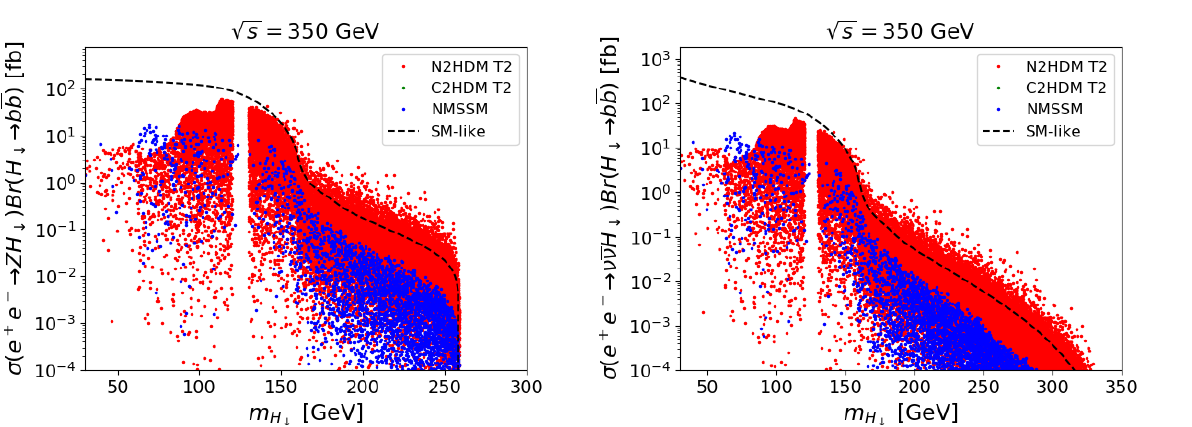
Figure 20. Achievable rates for various light scalar production modes at an e + e − collider with a com energy of 350 GeV, in various 2HDM variant models. Figure taken from